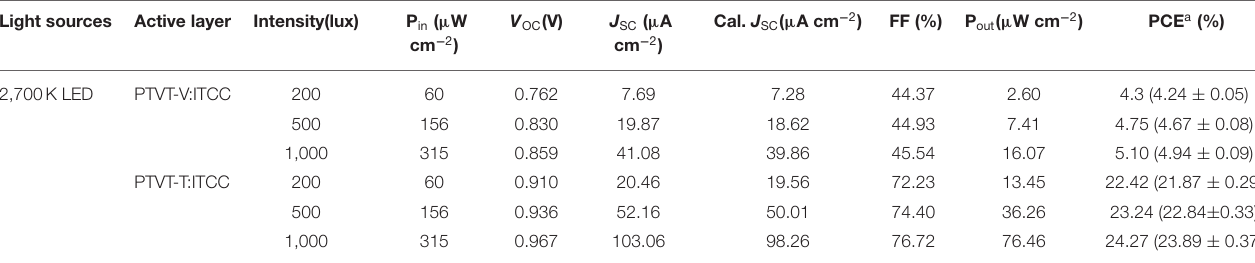
TABLE 2 | Photovoltaic parameters of the devices based on PTVT-V:ITCC and PTVT-T:ITCC under various light sources with different light intensities. Light sources Active layer